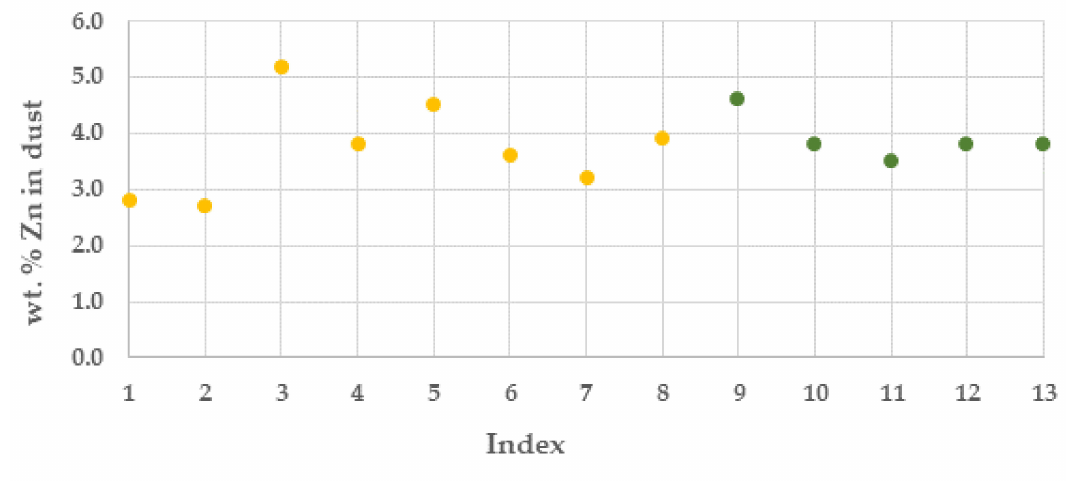
Figure 7. Zinc content (%) in OXYFINES dust from the pilot trial campaigns (campaign 1, yellow colour and campaign 2 green